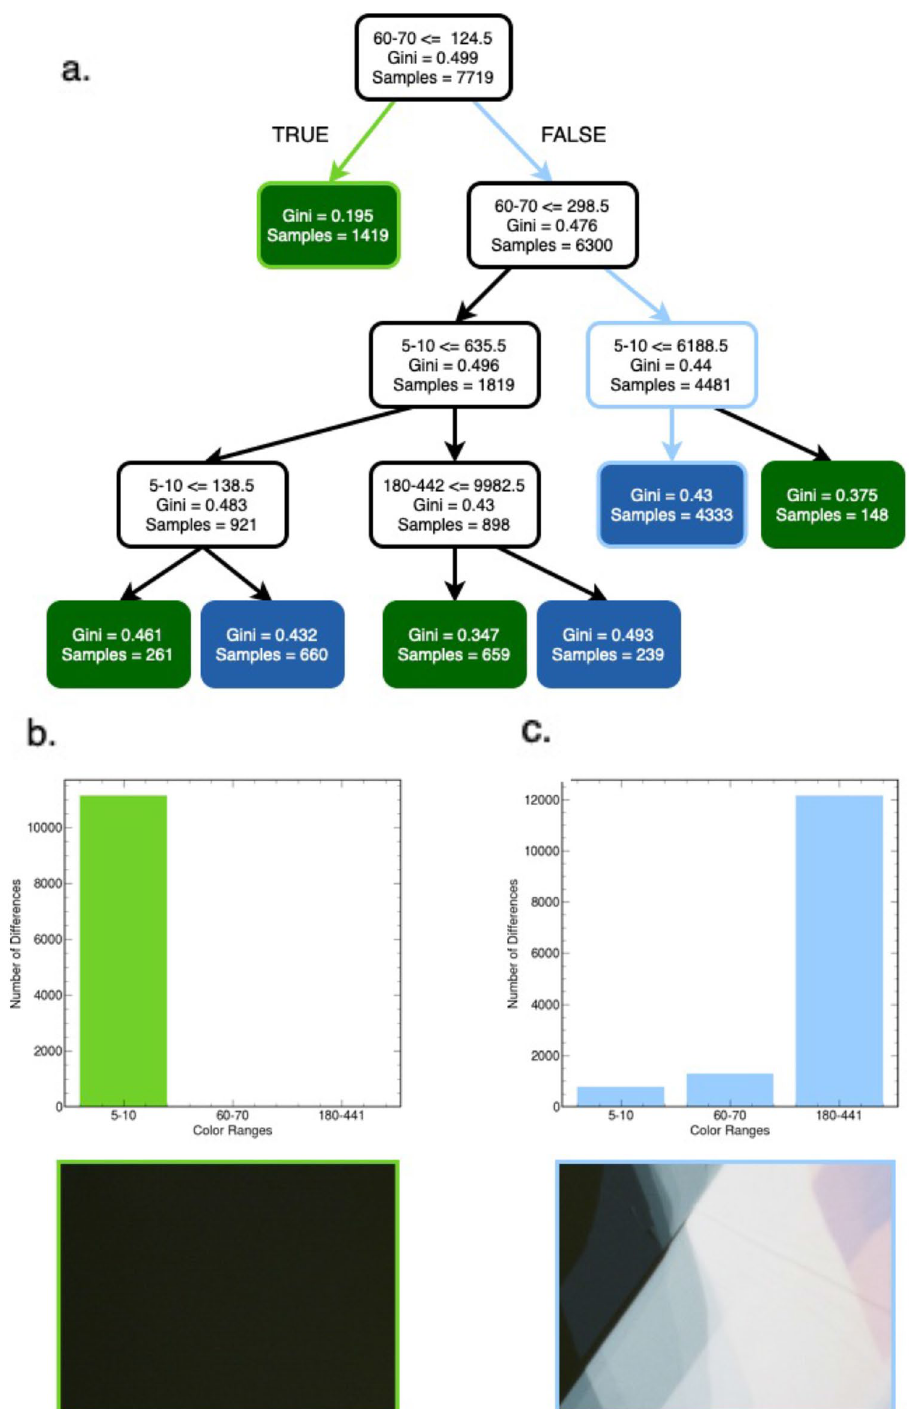
Figure 4. Visualization of decision tree after training. ( a ) Visualization of a decision tree classifier after training with 256 color clusters with a train and test accuracy of 73% and 67%. Each node shows the feature (number of color cluster differences in each range) used to indicate if the input image contains a 2D flake or not, the Gini impurity (a measure of the probability of misclassifying a random element when randomly classifying it based on the class distribution), the node’s samples, and classification if a terminal node (blue and green as flake and no flake). ( b ) An example of the tree traversal of an image without a flake and associated bins (colored light green) and ( c ) an image with a flake and associated bins (colored light